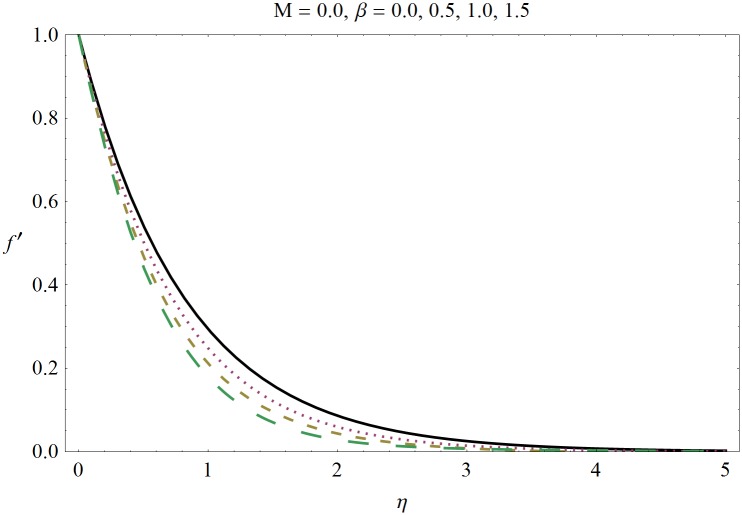
Influence of Deborah number β on f′.